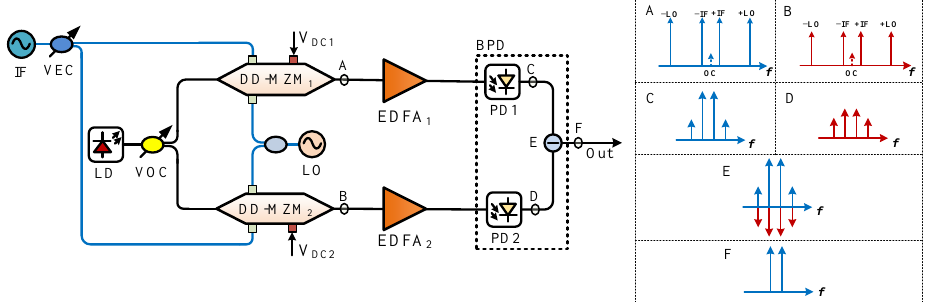
Figure 1. The schematic of the large dynamic frequency up-conversion system and the spectrum at different locations.